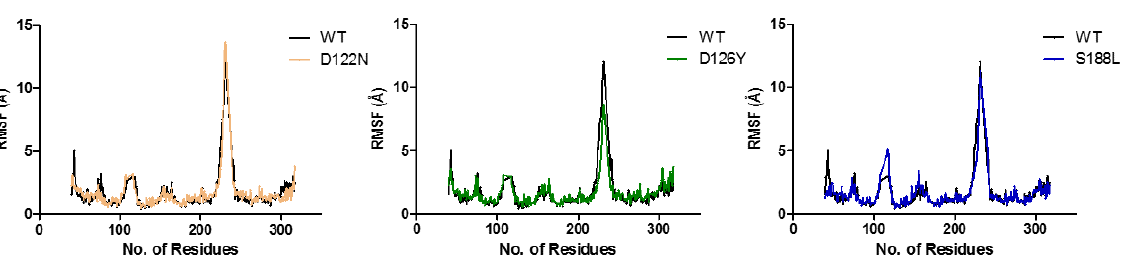
Figure 7. Root Mean Square Fluctuation (RMSF) analysis of the native and mutant forms of MC4R. RMSF plot shows the carbon backbone atom fluctuations in wild type and mutants.